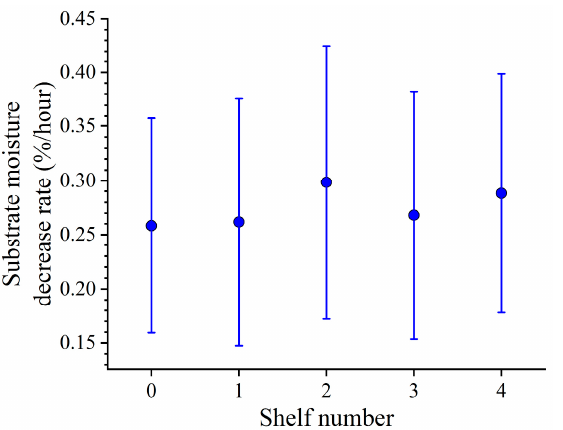
Figure 3. The plot of time- and container-averaged moisture decrease rate versus shelf number. As follows from this plot, the moisture decrease rate does not depend on the shelf number.